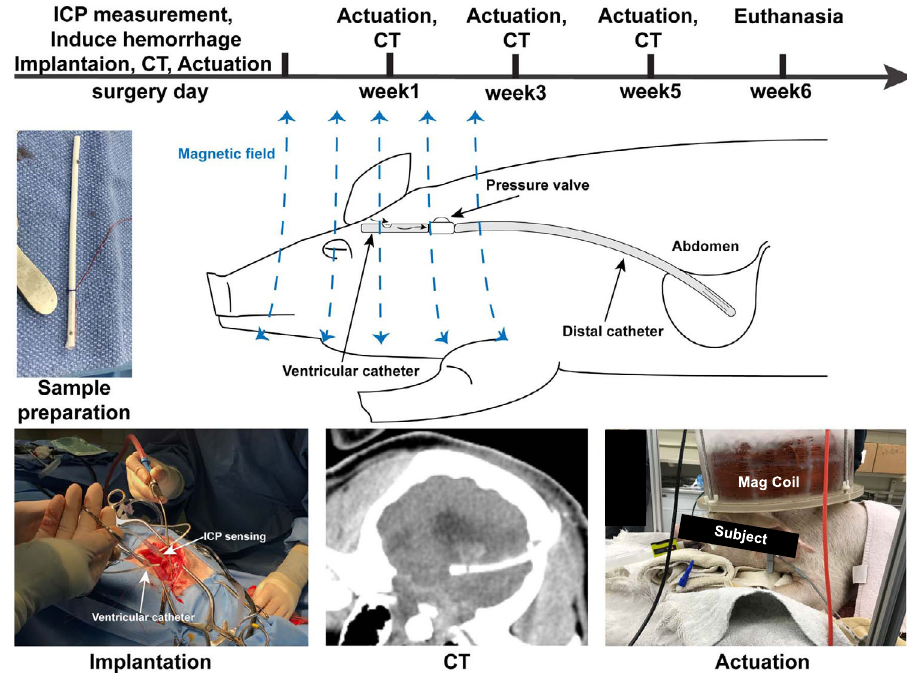
Fig. 4 In vivo experimental timeline. The entire study is designed to last 6 weeks. On surgery day, we measured the intracranial pressure (ICP), induced the intraventricular hemorrhage (IVH), and implanted a ventriculoperitoneal shunt. The computed tomography (CT) scan was performed before and after the surgical procedure, to measure the ventricular size and con fi rm ventricular catheter placement. Magnetic actuation (30 min) was performed for the Treated group immediately afterward. At weeks 1, 3, and 5, each surviving animal was subjected to 30 min of magnetic fi eld and CT scans. All surviving animals were terminated at week 6 for explantation and